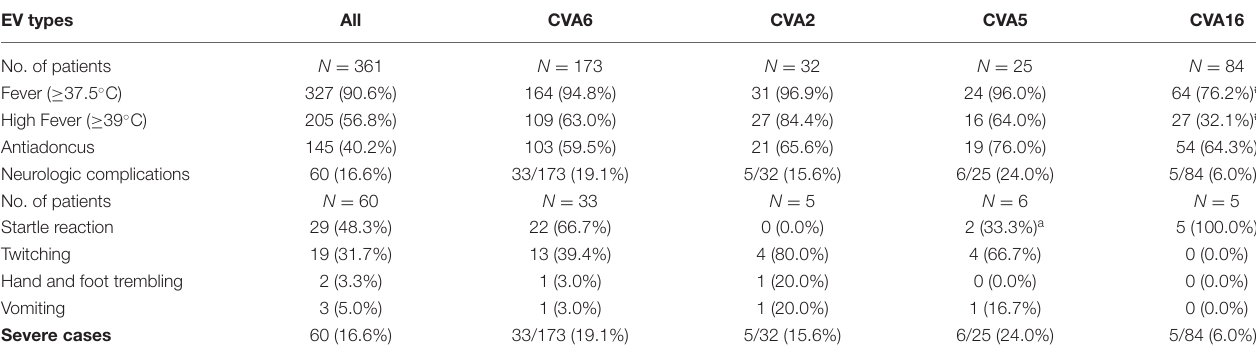
TABLE 3 | Clinical features of patients infected with different EVs on admission in this study.